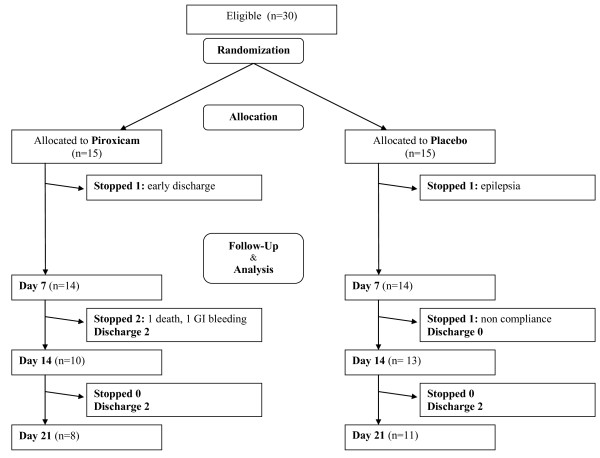
Flow chart. Numbers of patients at randomization, treatment allocation and each time point during follow-up.